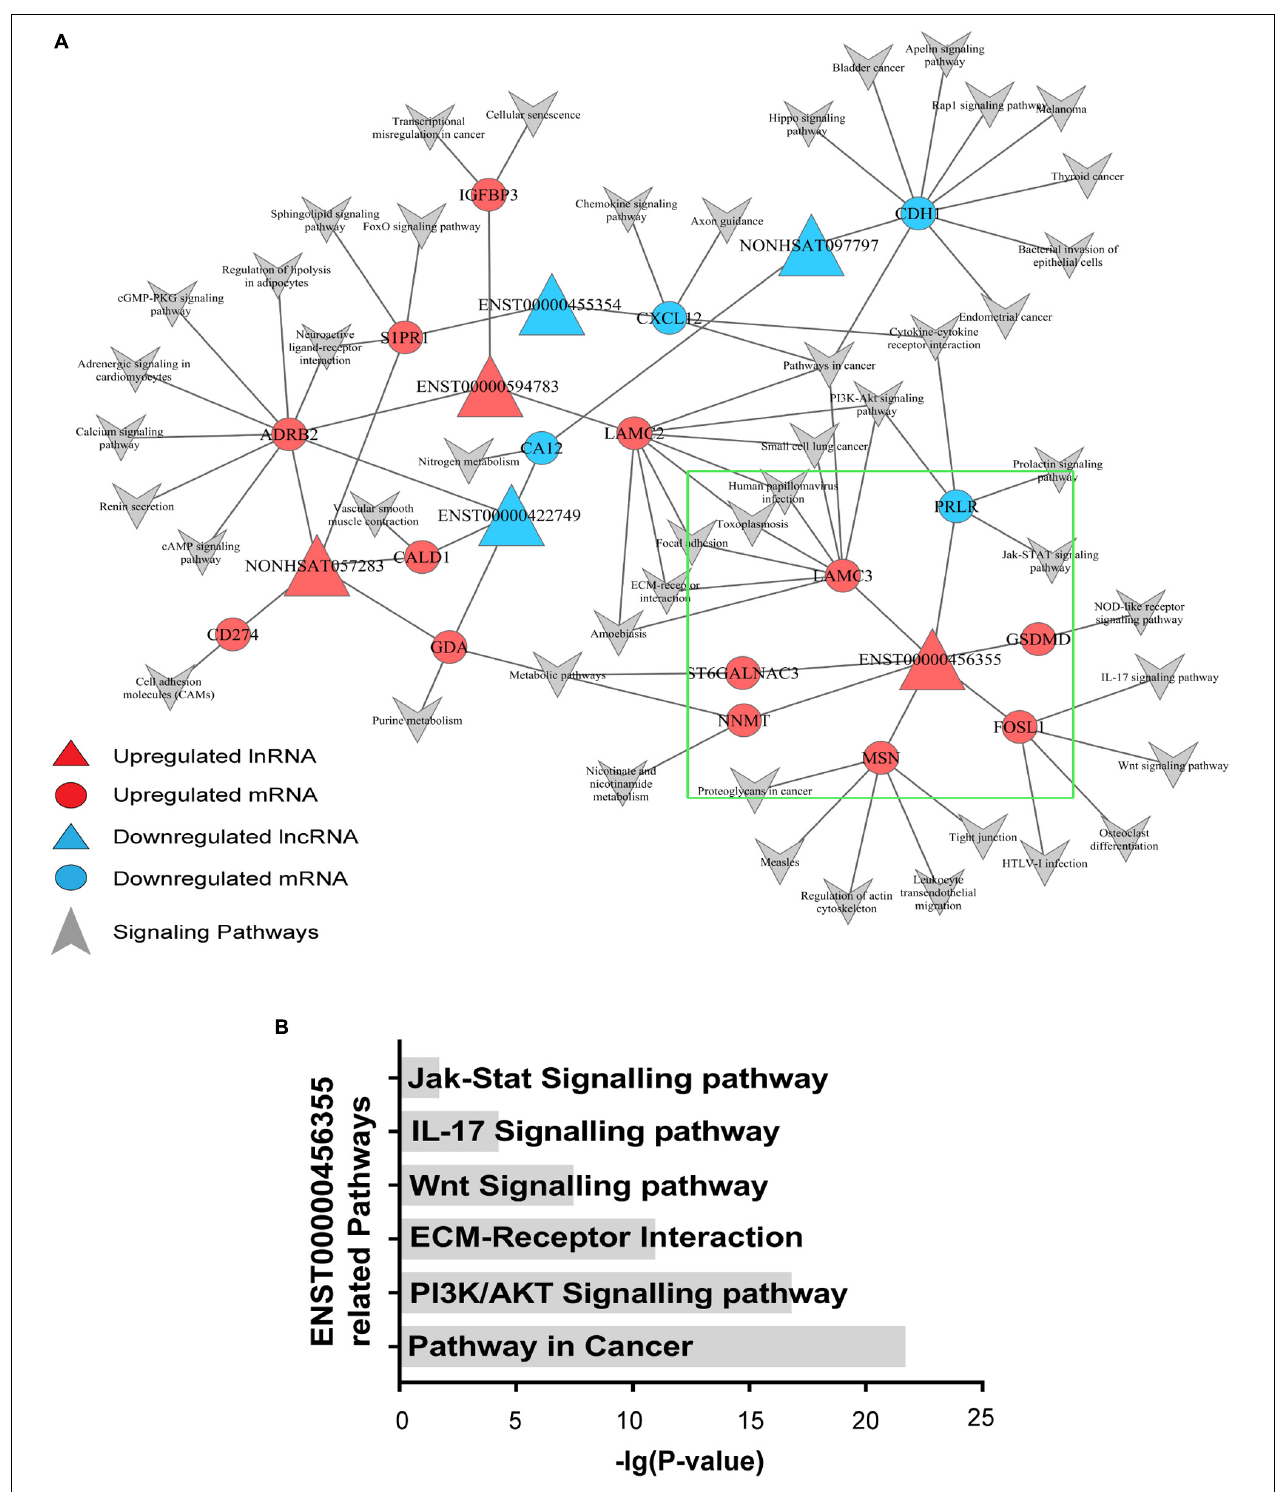
FIGURE 3 | Signaling pathway analysis of the lncRNAs. (A) An lncRNA–mRNA-pathway network was constructed with the six selected lncRNAs. Triangle nodes represent dysregulated lncRNAs, and circle nodes represent dysregulated mRNAs. The red nodes of lncRNAs and mRNAs indicate upregulated expression, while the blue nodes indicate downregulated expression. The arrows refer to the signaling pathways in which lncRNAs and mRNAs might participate. The lncRNAs in the red triangle area with larger nodes located in the center of the network indicate the key lncRNAs in the regulated network. (B) Pathways associated with lnc-TRDMT1-5 were found to be significant based on the P -value of lnc-TRDMT1-5.